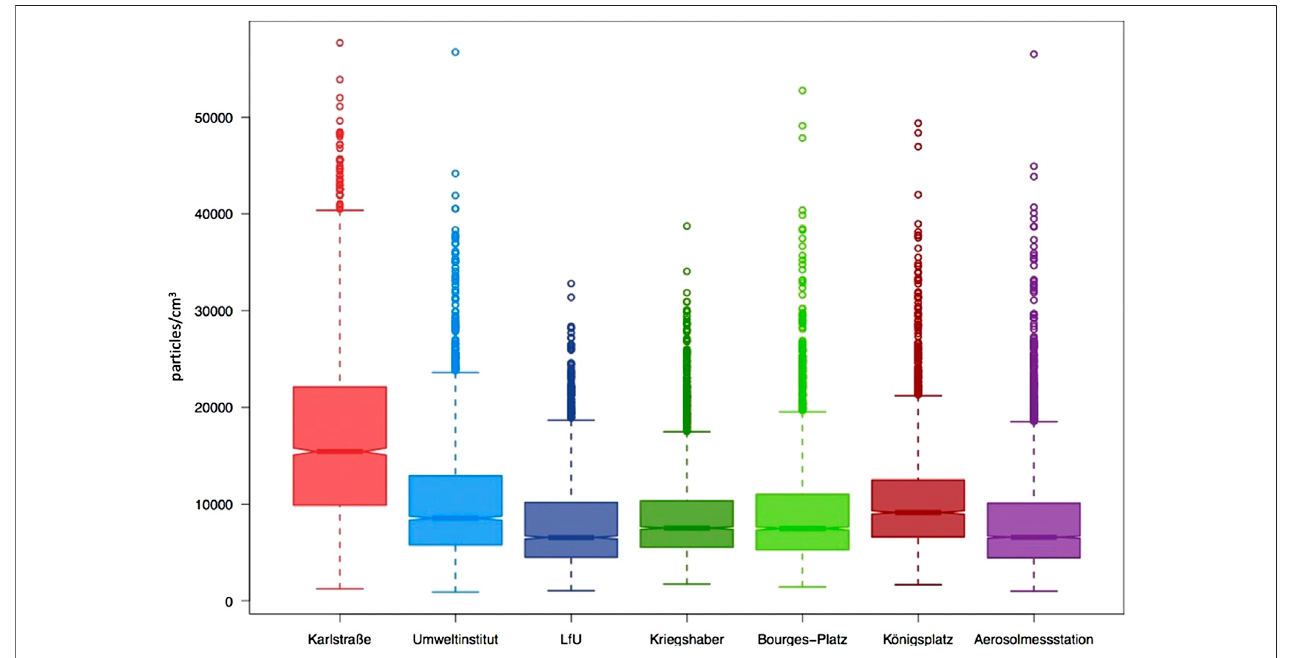
FIGURE 4 | Box-whisker plots of the UFP number concentrations differentiated according to the measurement